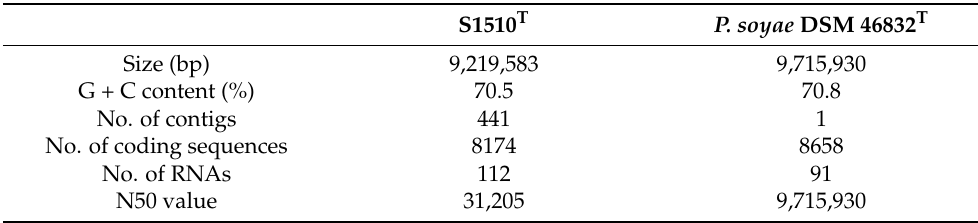
Table 1. Genome sequence characteristics of Plantactinospora sp. S1510 T and a closely related type strain.